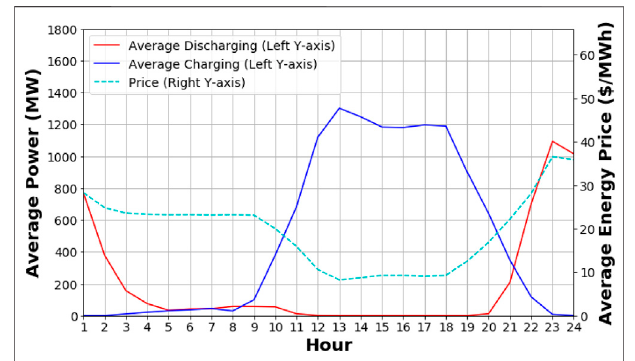
FIGURE 11 | Average daily discharge (generation), charging, and received price pro fi les for a 2,000 MW, 40% round-trip ef fi ciency, and 1- month duration energy storage device in 2050.